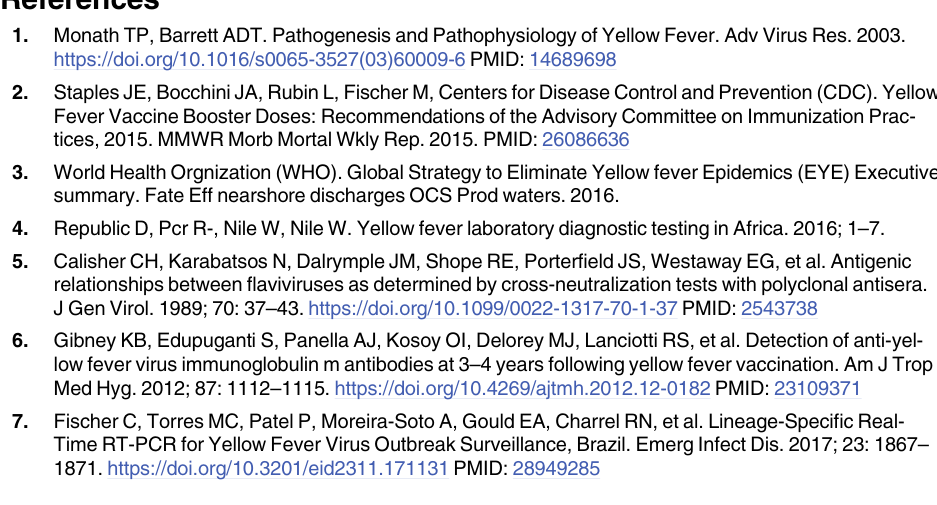
onto FTA card punches (10 μ L/ punch) and allowed to dry completely. RNA was then extracted from punches made from the whole FTA card or the pre-punched samples. The dot- ted line at C value 37 indicates the cut-off for YFV RNA positivity and is based on cut-offs t used in the molecular diagnosis of YFV in the field. Dilutions were performed in PBS. Points and error bars represent the average of two experiments and data was fit using a linear regres- sion. S3 Fig. Experimental design of effects of humidity YFV RNA yield from FTA cards. Made using